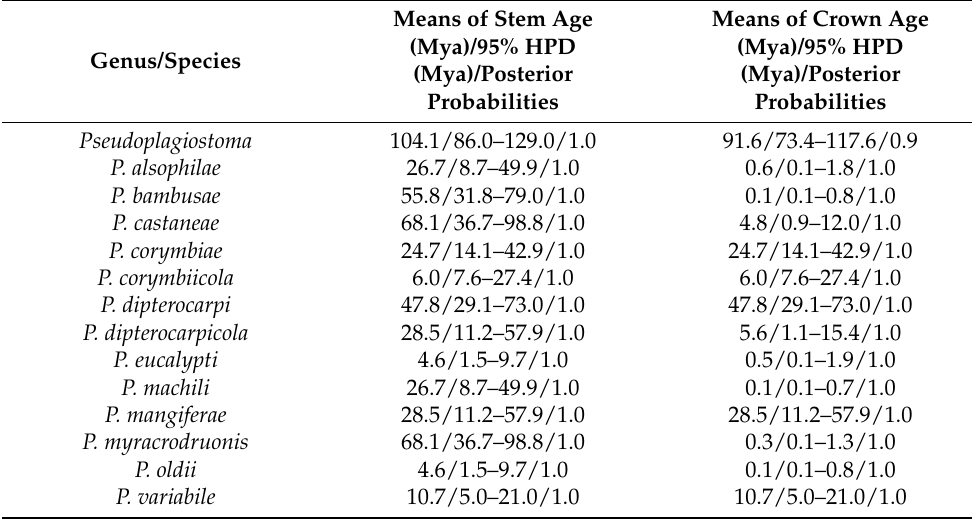
Table 3. Inferred divergence time of species in the genus Pseudoplagiostoma